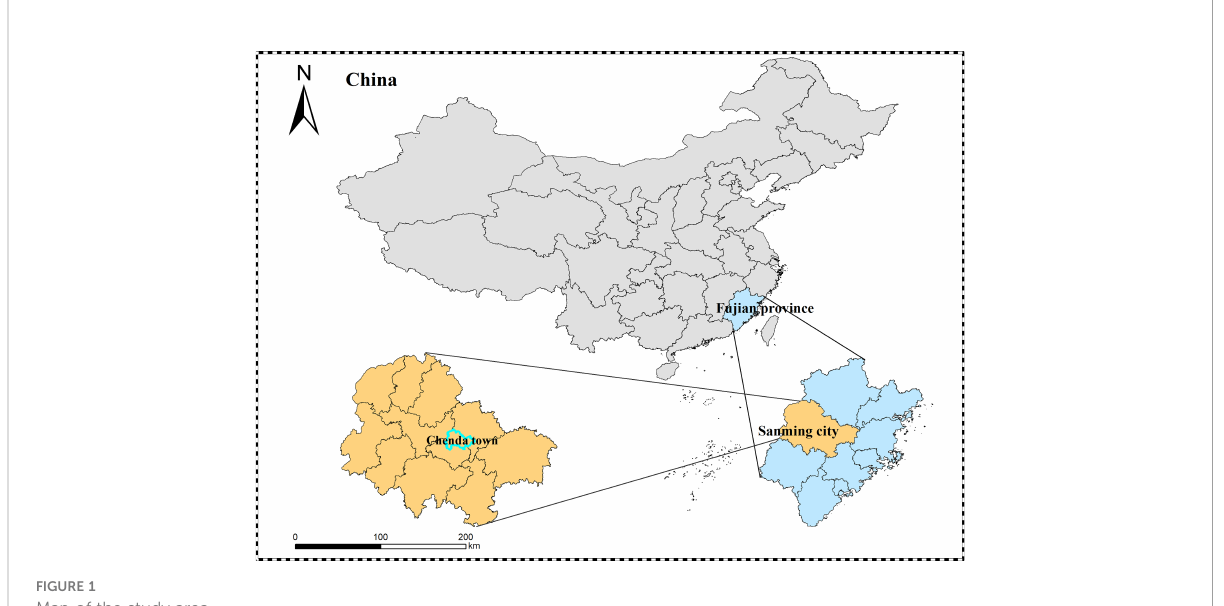
FIGURE 1 Map of the study